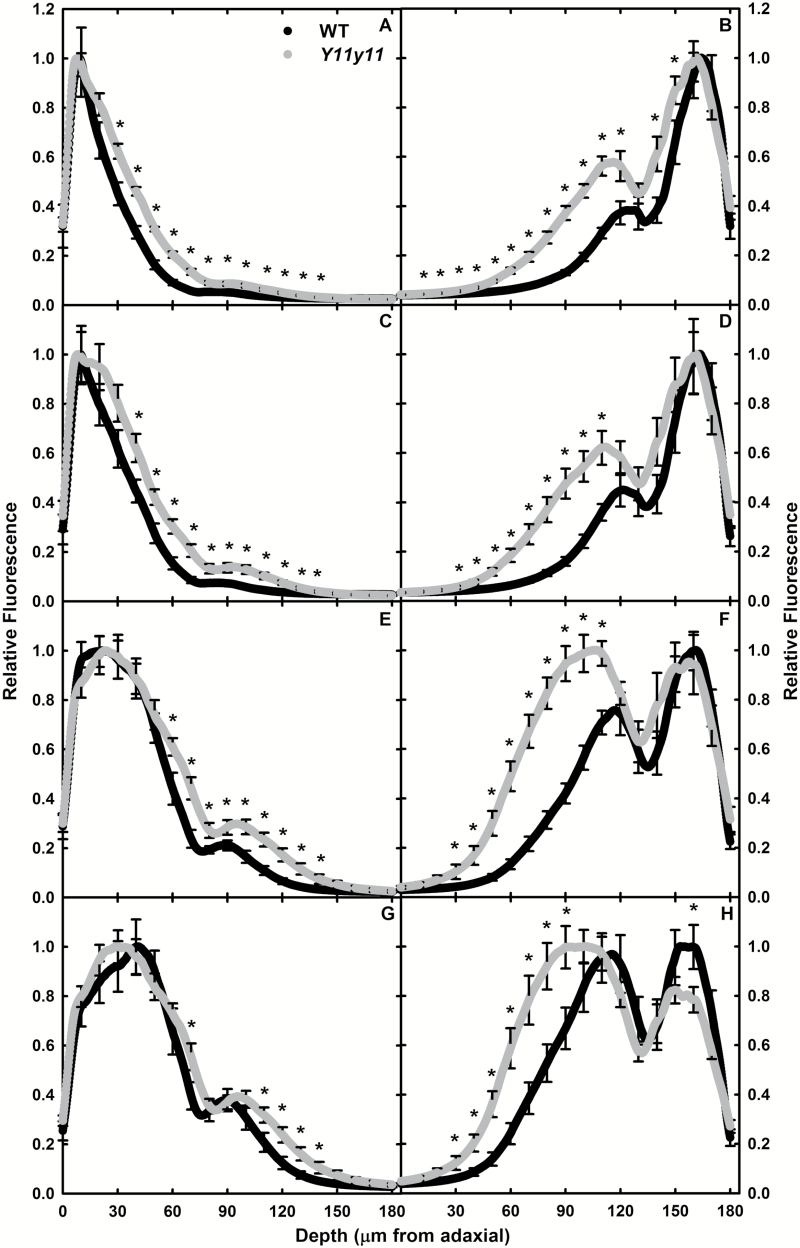
Relative fluorescence with distance from the adaxial surface. WT (black) and Y11y11 (grey) field-grown leaves were illuminated with 405nm (A, B), 488nm (C, D), 638nm (E, F), and 561nm (G, H) lasers from the adaxial (A, C, E, G) and abaxial (B, D, F, H) surface using light sheet microscopy. Means (n=6) are shown every 0.23 µm. Error bars are indicated every 10 µm. Asterisks represent significant differences at P<0.05.